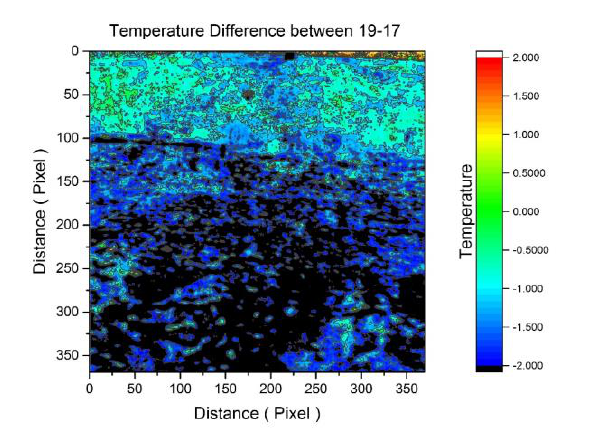
Figure 3 (b) Temparature diference between 19h-17h